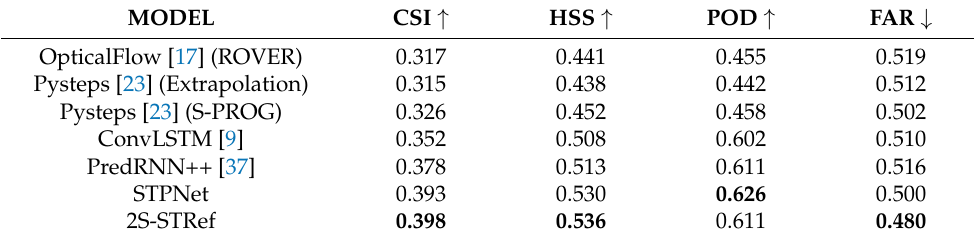
Table 7. Skill score at R > 35 dBZ (two-hour prediction).